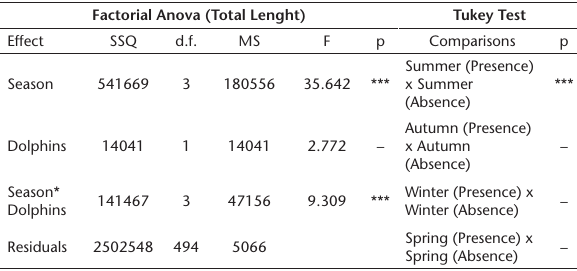
Table 5. Seasonal comparison of body size (total length, mm) of mullets with the presence or absence of dolphins. Factorial ANOVA results indicate sum of squares (SSQ), degrees of freedom (d.f.), average square (MS), F value and Tukey’s